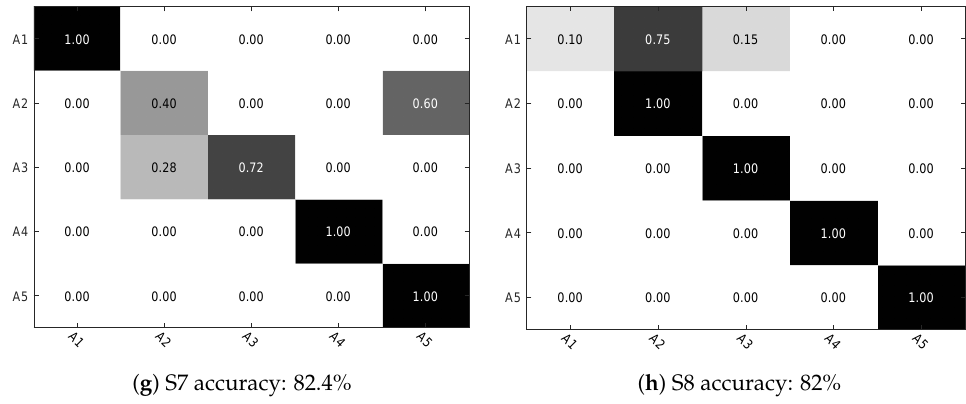
Figure 9. Confusion matrix of predicted activities for each subject.